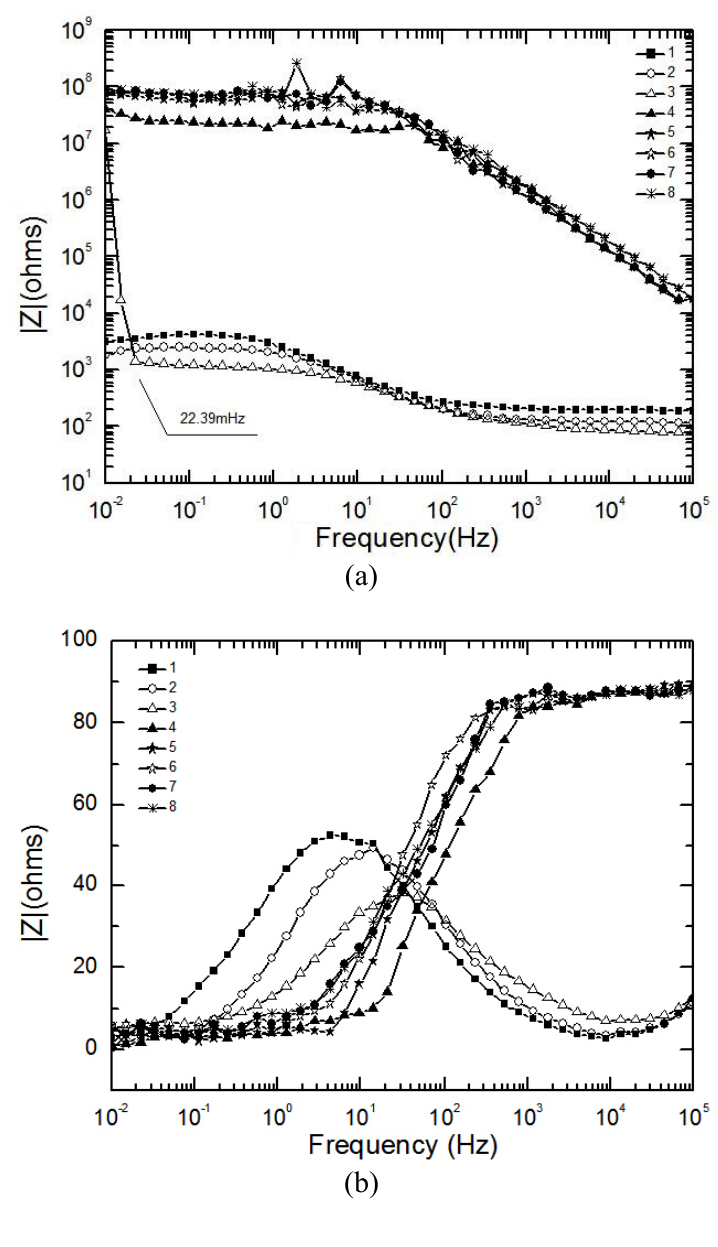
Figure 5. EIS results of 1 st cycle. (a) Bode diagram (|Z|). (b) Bode diagram (Phase of